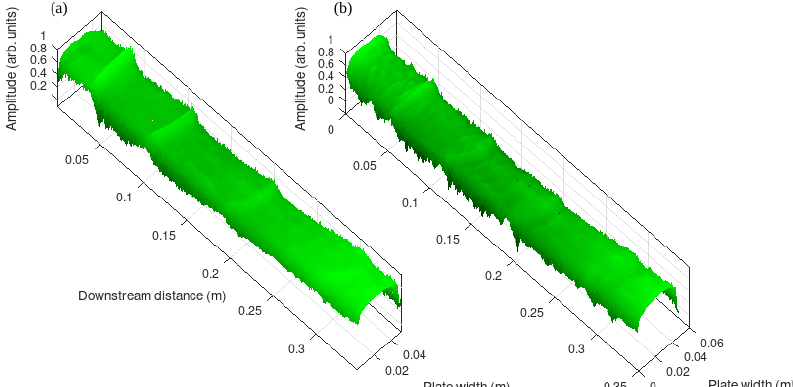
Figure 2. Instantaneous profiles of the surface waves in a liquid film flowing over the inclined plate. The profiles were obtained from the fluorescence images. The frequency of the flow forcing resulting in the formation of solitary-like waves is 2Hz. ( a ) No vibration. ( b ) The inclined plate is vibrated with the frequency of 48Hz and the peak vibration amplitude of 1